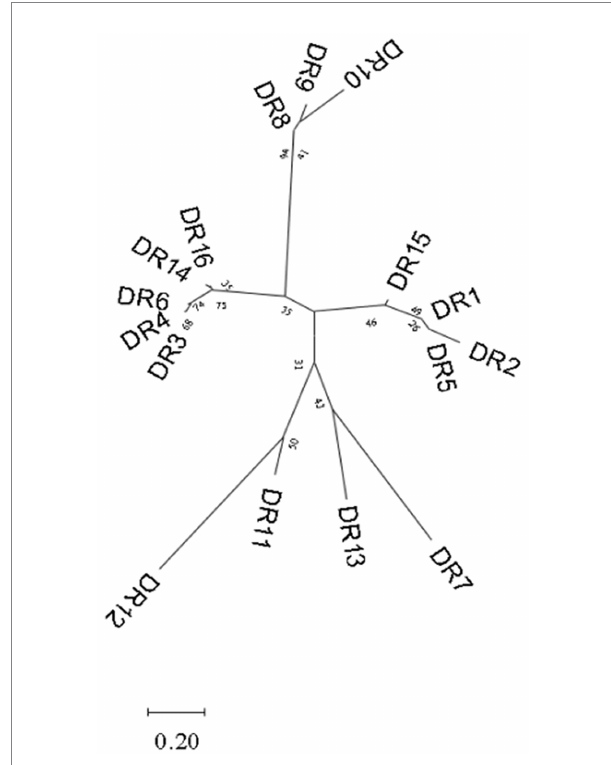
FIGURE 3 Phylogenetic tree constructed based on 16 groups of repeat sequences of Enterococcus . They can be divided into two groups.